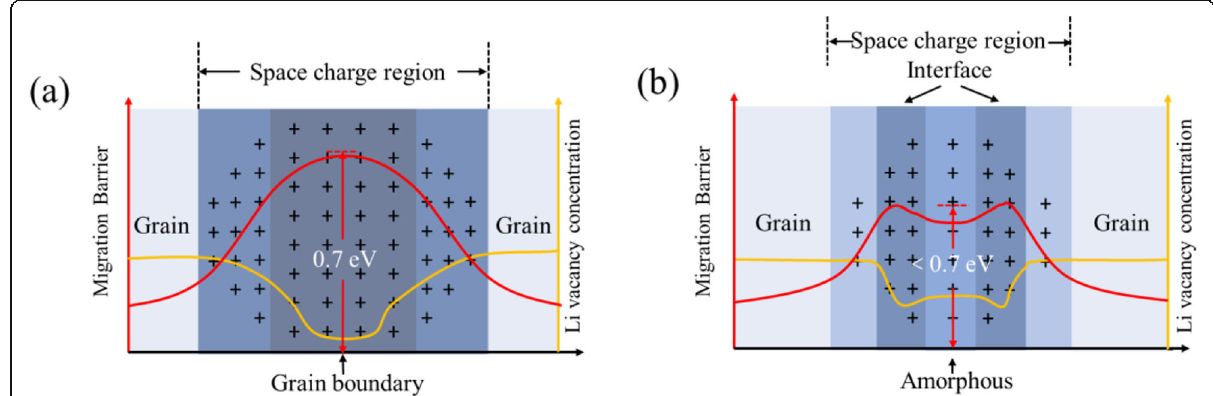
Fig. 1 Illustration of the migration barrier and Li vacancy concentration at the conventional grain boundary ( a ), and the grain boundary with amorphous domains ( b )